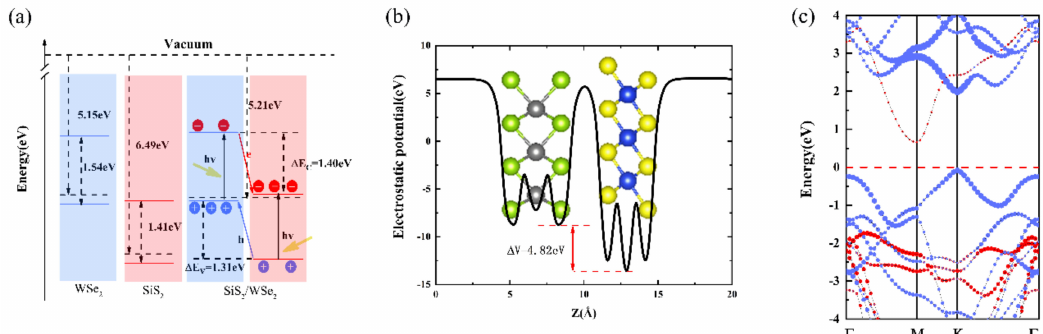
Figure 3. ( a ) Band alignment and ( b ) electrostatic potential of AB-2 SiS 2 / WSe 2 hetero-bilayer obtained by GGA-PBE method. ( c ) Projected band structure of AB-2 SiS 2 / WSe 2 hetero-bilayer obtained by the HSE06 method’ red and blue lines are bands contributed by SnS 2 and WSe 2